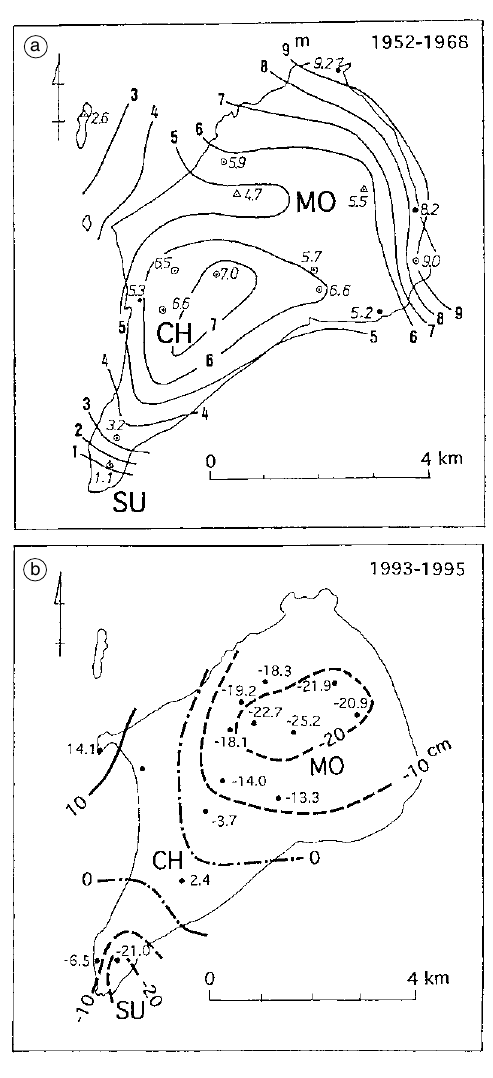
Fig. 8a,b. Crustal movements at Iwojima. a) Uplift (m) during the period 1952~1968 obtained by geodetic methods (after Tsuji et al ., 1969); b) Deformation (cm) during the period 1993~1995 obtained by precise levels. This is comparable with the result obtained by interferometric SAR images (after Ohkura,